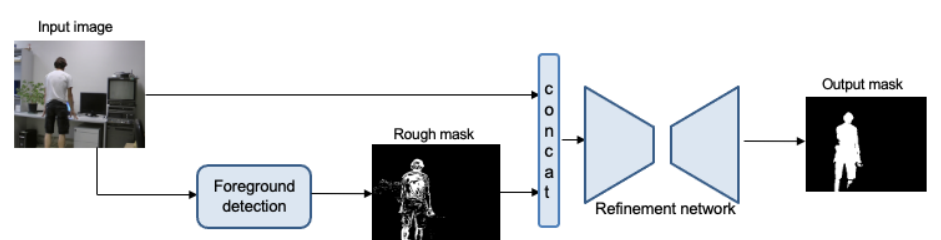
Figure 1. Pipeline of the mask refinement network at test